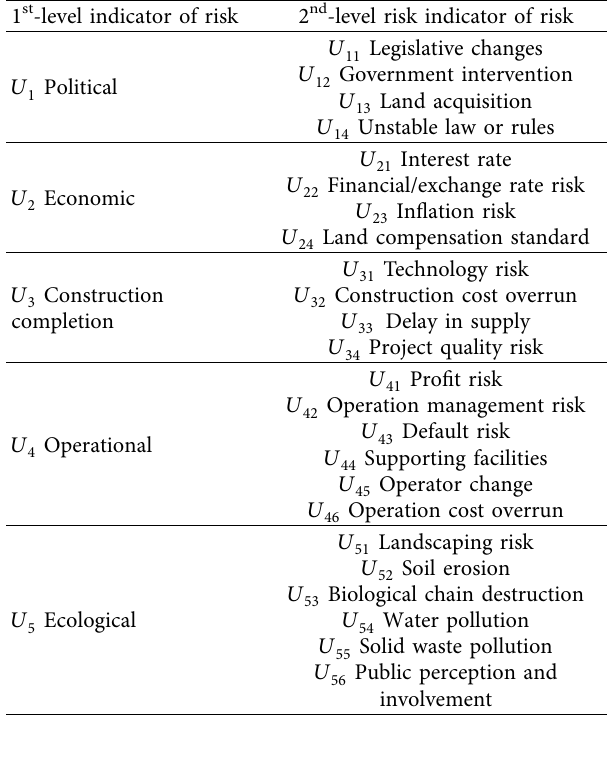
Table 2: Evaluation indicators in water environment treatment PPP project